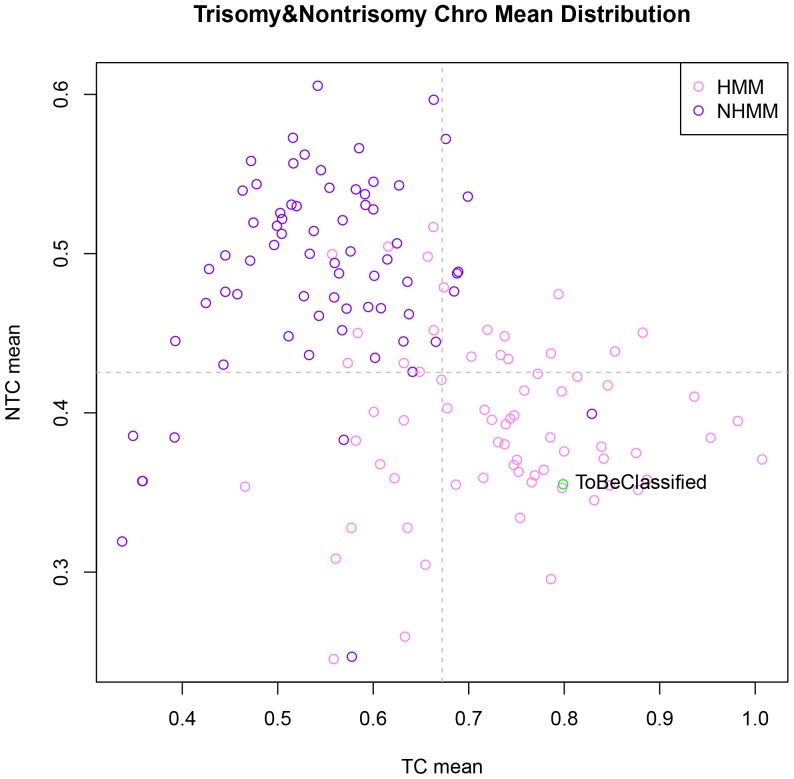
Scatterplot of trisomy and nontrisomy chromosome means of GSE6477 samples.Each point represents a patient sample. ‘TC mean’ on X-axis is the average scaled expression values for the genes on the 8 trisomy chromosomes. ‘NTC mean’ on Y-axis is the average scaled expression values for the genes on nontrisomy chromosomes. The light purple circles are HMM samples and the dark purple circles are NHMM samples determined by FISH. The green circle is the left-out sample to be classified.